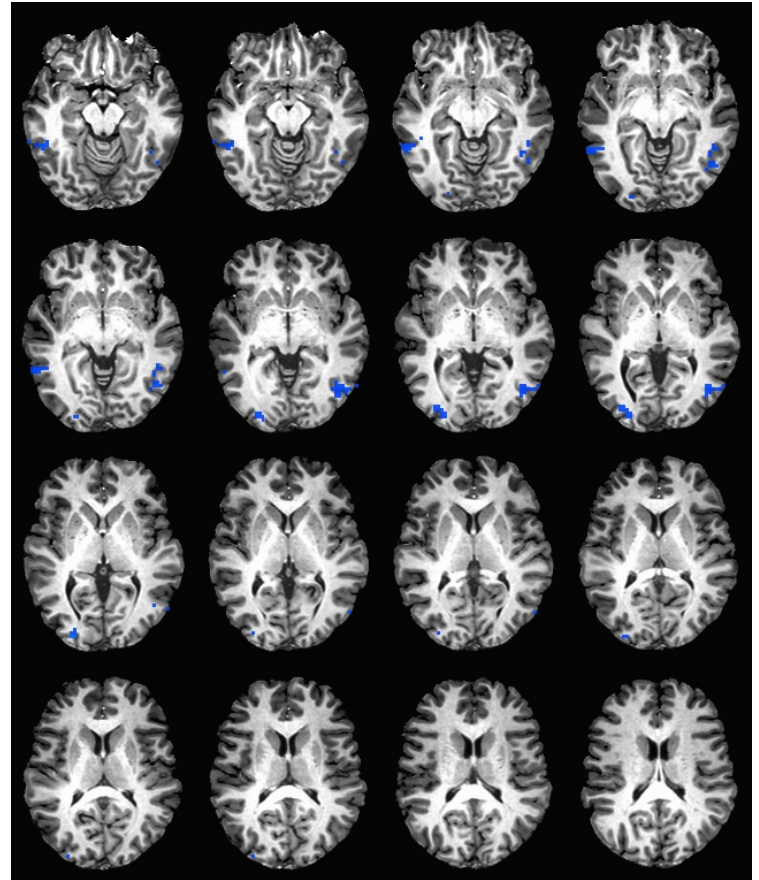
Figure 3. Brain activation during the hedonic evaluation of saccharin. Blue indicates areas where caffeine consumers had significantly greater activation in comparison to caffeine non-consumers.